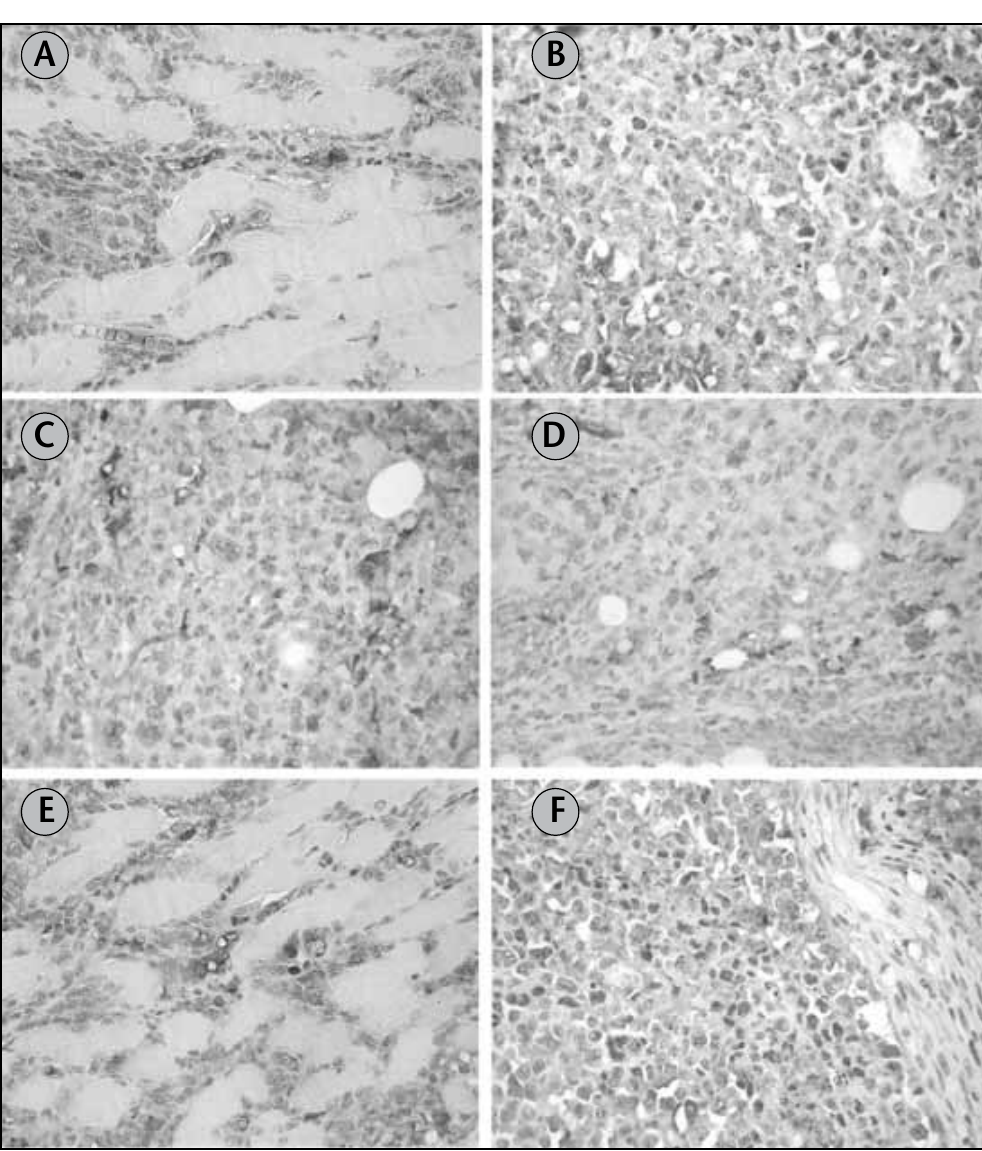
Figure 4 – Immunohistochemical reaction for CD31/TLD-3A12 protein in Ehrlich tumor Group 1: control (A) and treated (B) animals at day 6 post tumor cell inoculation; group 2: control (C) and treated (D) animals at day 12; group 3: control (E) and treated (F) animals at day 18. Citoplasmatic immunolabeling, showing low number of positive cells in Kint3-4 treated animals of the three groups. 400 ×